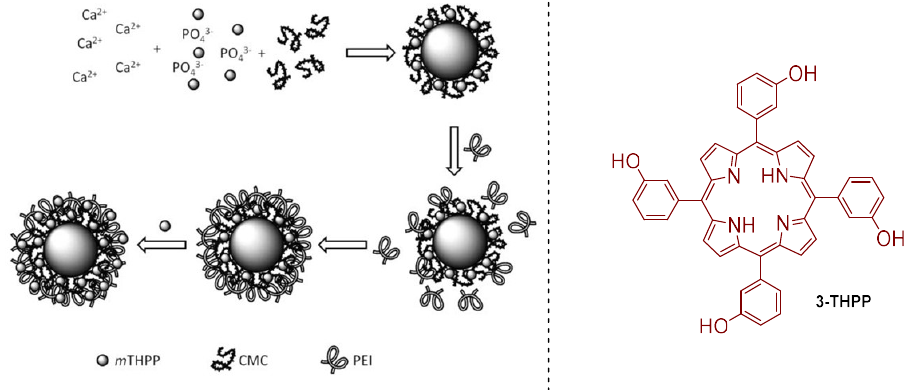
Figure 37. Schematic representation of NP containing calcium phosphate core with shells of carboxymethyl cellulose (CMC, anionic), poly(ethyleneimine) (PEI, cationic) and 5,10,15,20-tetrakis(3-hydroxyphenyl)porphyrin ( 3-THPP ). Reprinted with permission from Ref. [197]. 2009, Springer Nature.